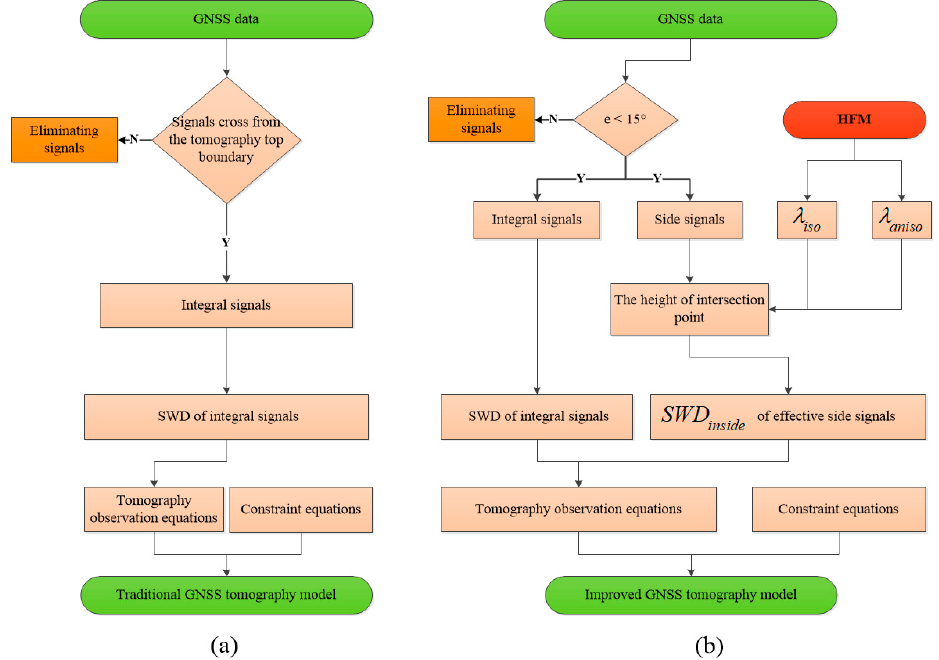
Figure 6. A comparison of the flow chart of the traditional tomography model ( a ) and the improved model ( b ) .